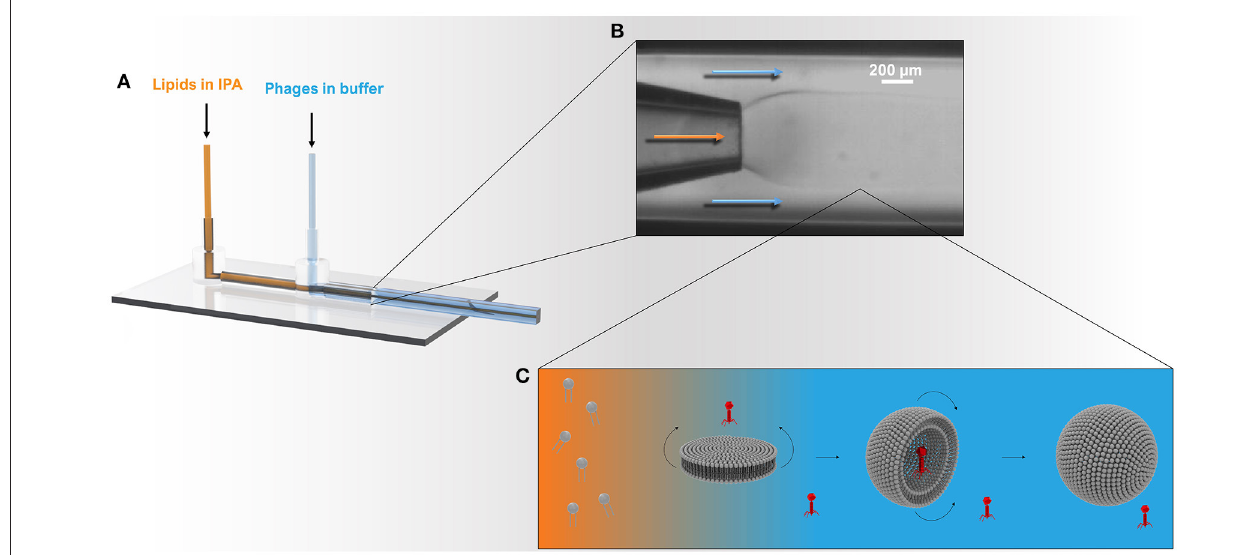
FIGURE 1 | Schematic showing the microcapillary micromixing device for the production of liposomes. (A) 3D model of the co-axial glass capillary device. Solutions were pumped using two microfluidic pumps using a total flow rate of ∼ 1ml h − 1 and a flow rate ratio (FRR) of aqueous to organic phase (Q a :Q o ) of 2:1. (B) The round capillary was inserted into a square capillary that delivered the aqueous phase containing phages. The internal round capillary delivered the lipid dissolved in IPA solution. (C) Once the organic phase mixes with the aqueous phase, the phospholipids experience a highly polar environment that leads to self-assembly of lipids into bilayer discs. The latter grow in the radial direction by collision with other discs or through addition of phospholipid molecules from solution. When the disc bending energy is overcome by the energy gain when the edge around the bilayer disc is removed, the planar bilayer closes upon itself resulting in a spherical structure entrapping the surrounding solution and any phages in the vicinity of the